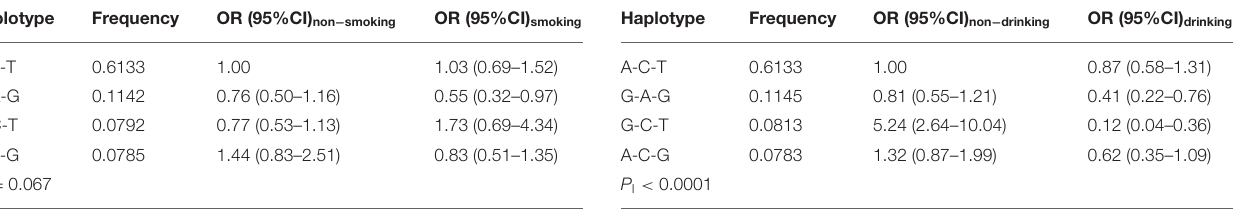
TABLE 9 | Interactions of the haplotypes and drinking on the risk of IS.